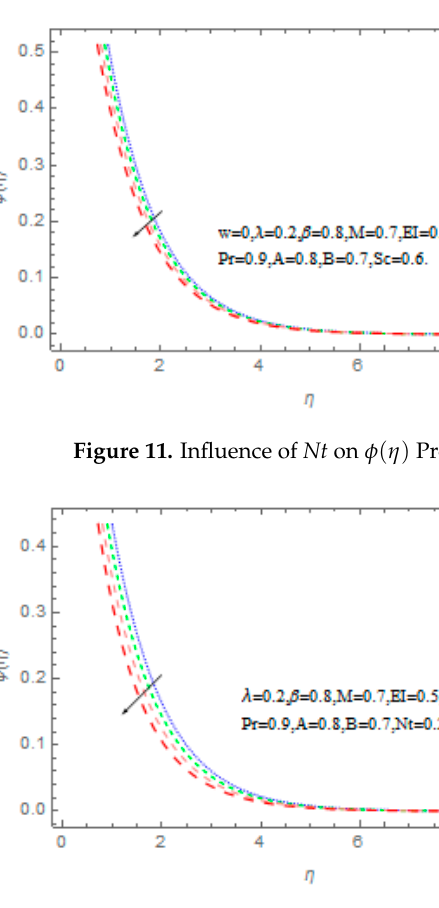
Figure 12. Influence of Sc on φ ( η ) of the fluid.